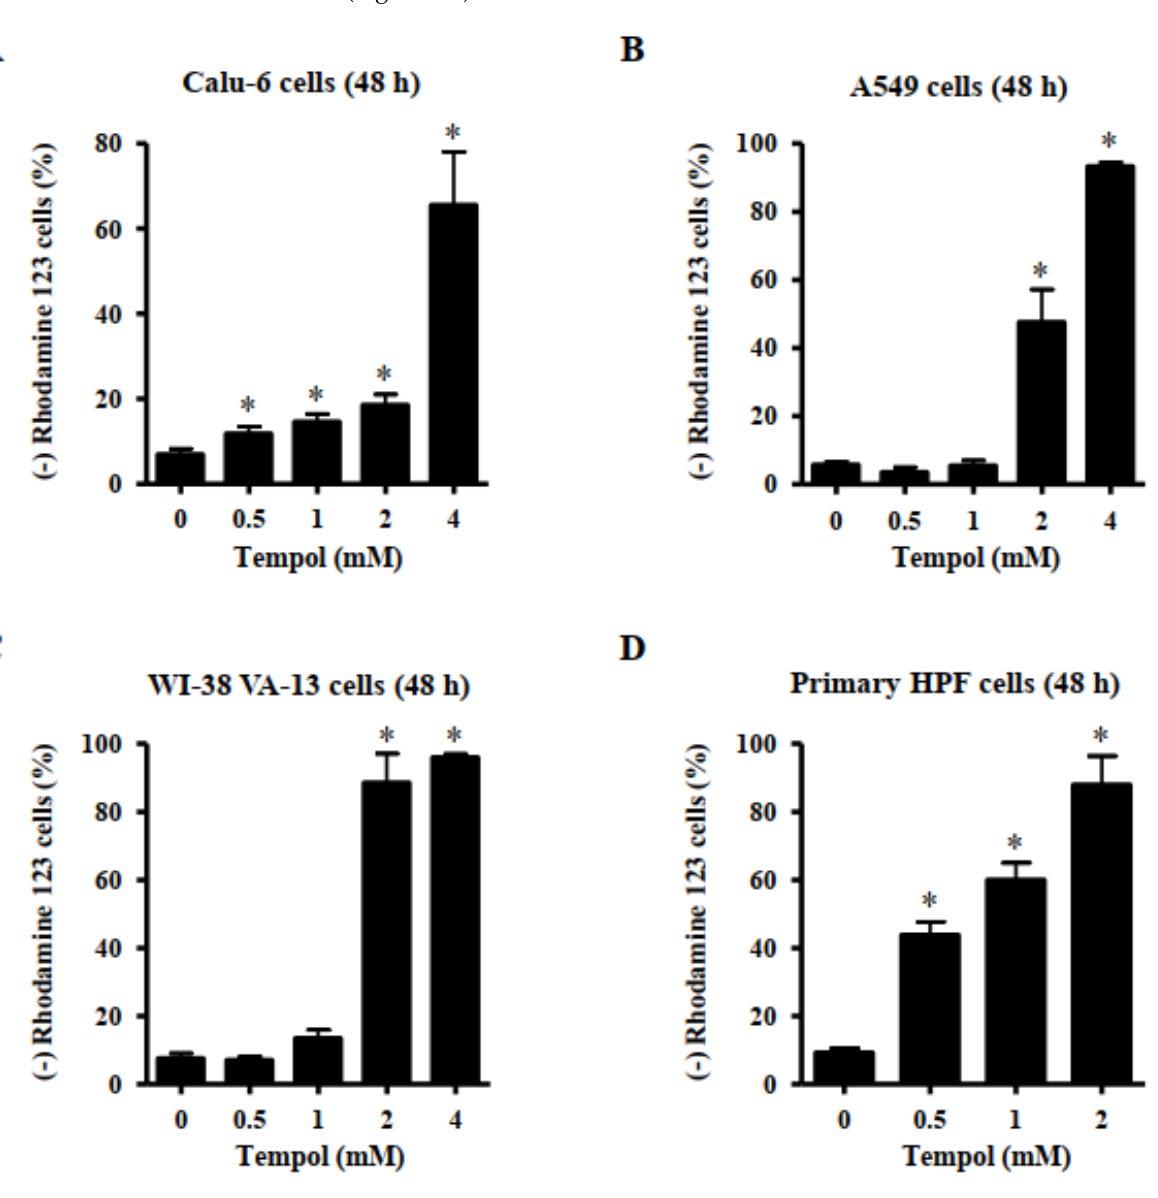
Figure 4. Effects of Tempol on MMP ( ∆Ψ m) levels in lung cancer and normal cells. Exponentially growth of cells incubated with Tempol at indicated concentrations for 48 h. MMP ( ∆Ψ m) in lung cells was measured using a FACStar flow cytometer. Graphs show the proportion of rhodamine 123-negative [MMP ( ∆Ψ m) loss] Calu-6 cells ( A ), A549 cells ( B ), WI-38 VA-13 cells ( C ), and primary HPF cells ( D ). Student’s t -test was used. * p < 0.05 compared to Tempol-untreated control cells.